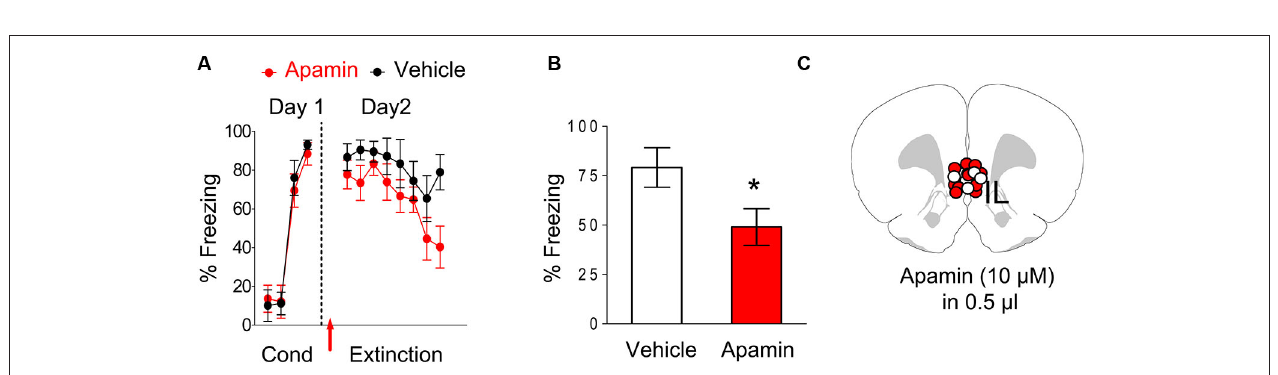
FIGURE 1 | Blockade of SK channels with apamin increases the intrinsic excitability of IL pyramidal neurons. (A) Voltage-clamp recordings showing that bath application of the SK channel antagonist apamin (100 nM) blocked the I AHP . (B) Traces showing the number of spikes evoked by a current pulse during baseline and following the application of apamin. Inserts below show the overlapping fAHPs, following the second